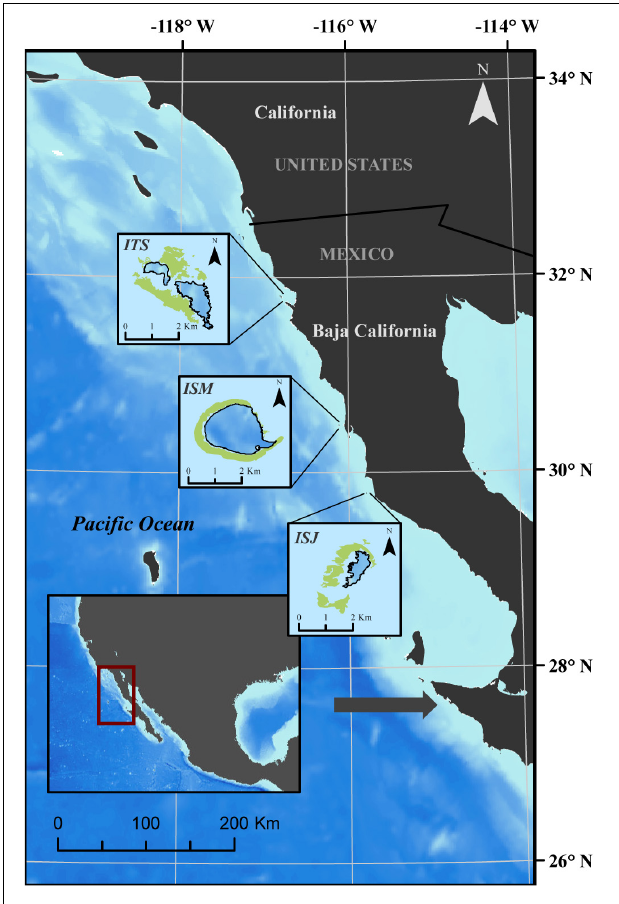
FIGURE 1 | Location of Isla Todos Santos (ITS), Isla San Martin (ISM), and Isla San Jeronimo (ISJ) in Baja California, Mexico. Green polygons in the insets represent M. pyrifera beds at the three islands. The dark arrow in the main figure shows the southern distribution limit of M. pyrifera in the CCS.